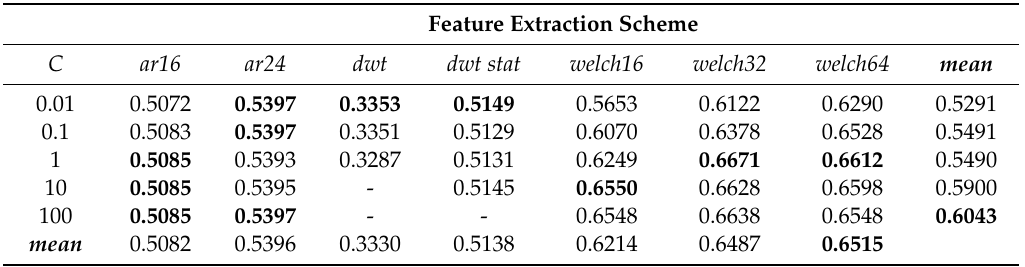
Table 8. Accuracy of test data classification with support vector machine (SVM)-linear classifier for chosen values of C parameter.